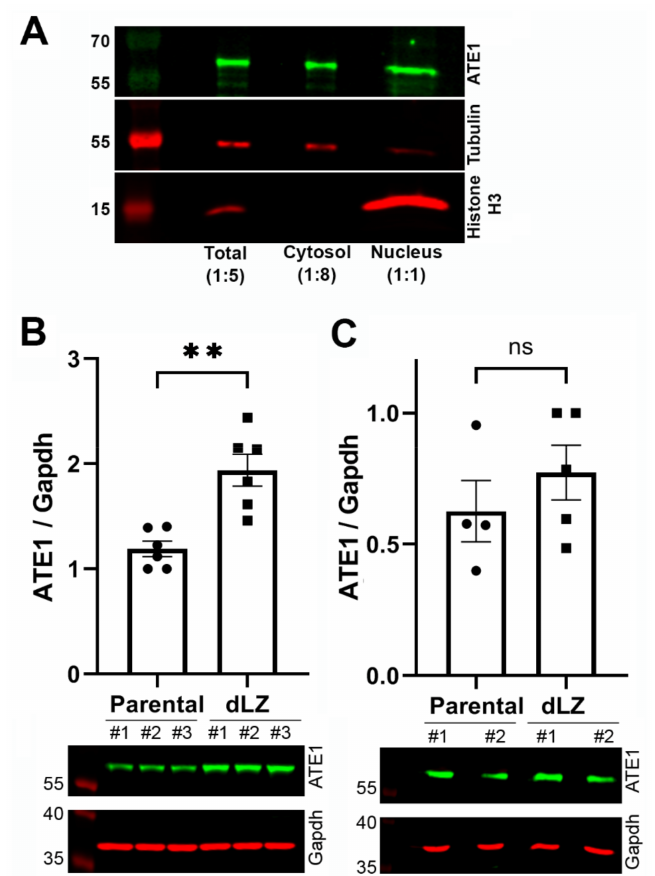
Figure 6. Displacement of the long RARS from the multi-synthetase complex induces ATE1 redis- tribution into the cytosol. ( A ) Sample fractionation showing the relative levels of ATE1 in the total extract (total), the cytosol and the nuclear fraction, probed with tubulin (a largely cytosolic marker) and histone H3 (a nuclear marker) to confirm the fractionation efficiency. ( B ) Chart and representative immunoblots of ATE1 levels in the cytosol of wild-type (parental) and dLZ cells. ( C ) Chart and representative immunoblots of total ATE1 levels in wild-type and dLZ cells. Error bars represent the SEM; n = 3 biological replicates. ** p < 0.01, Welch’s t